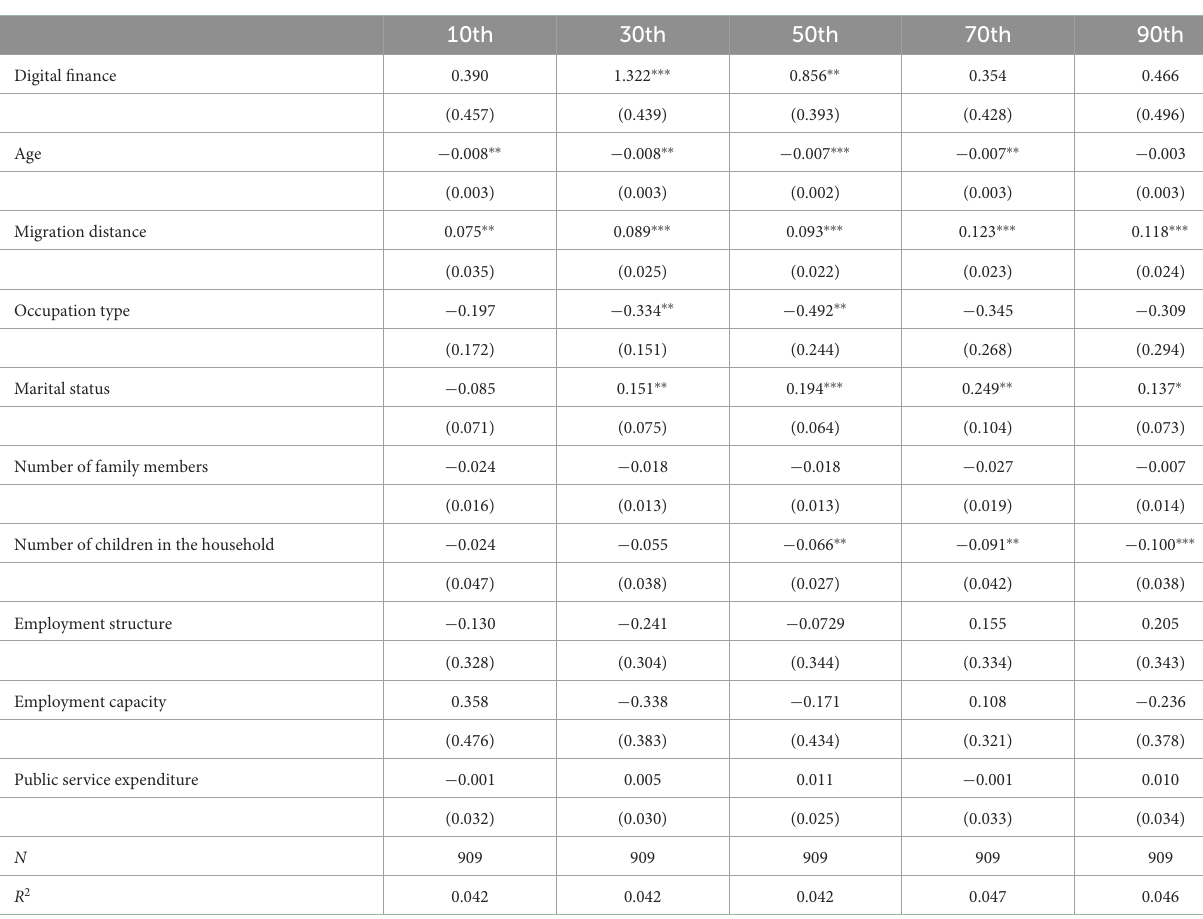
TABLE 6 The results of quantile